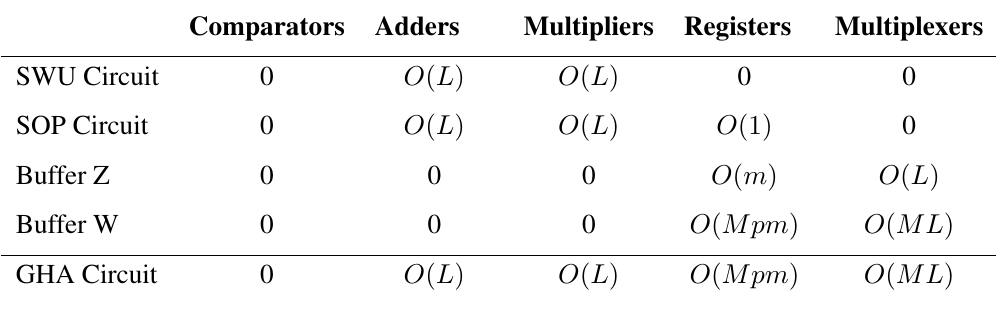
Table 1. The area complexities of the GHA circuit.